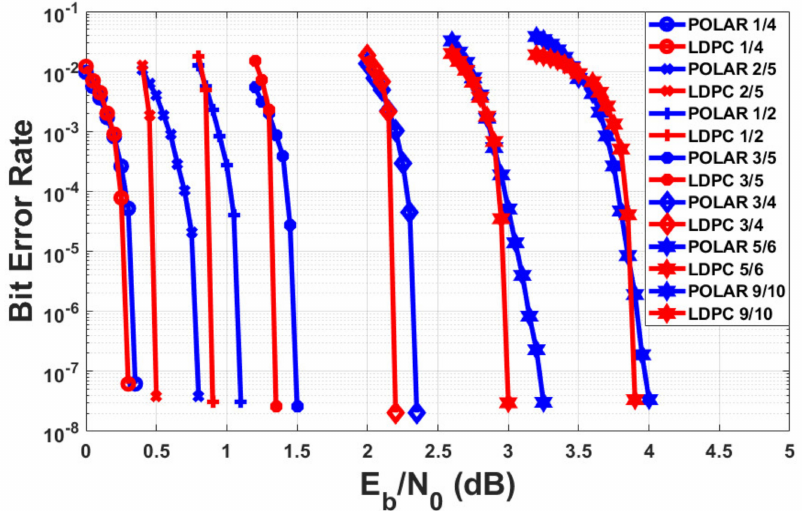
Figure 8. BER versus E b / N 0 for LDPC & optimized polar codes for normal frame with N = 64,800 and different code rates R in DVB-S2.